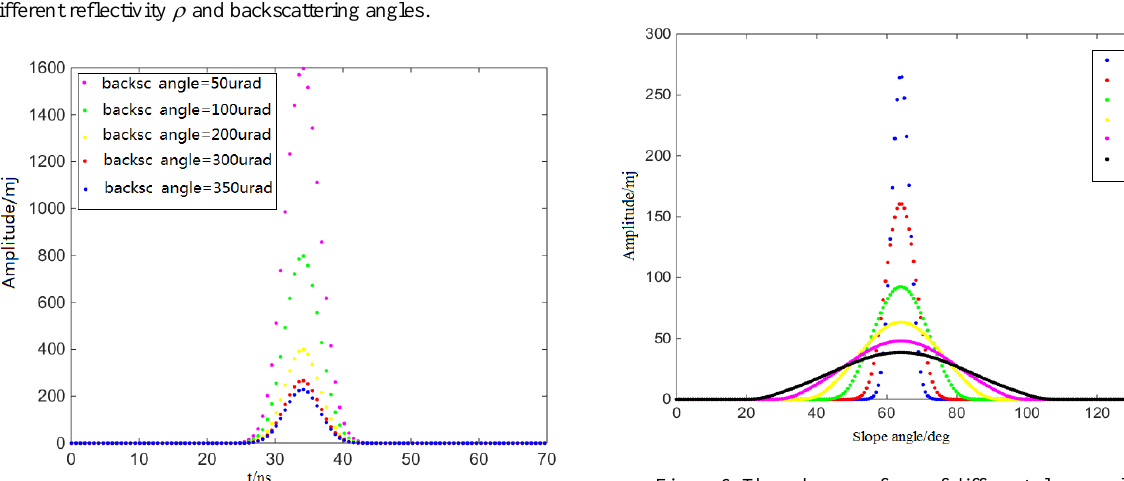
Figure 6. The echo waveform of different slope angles